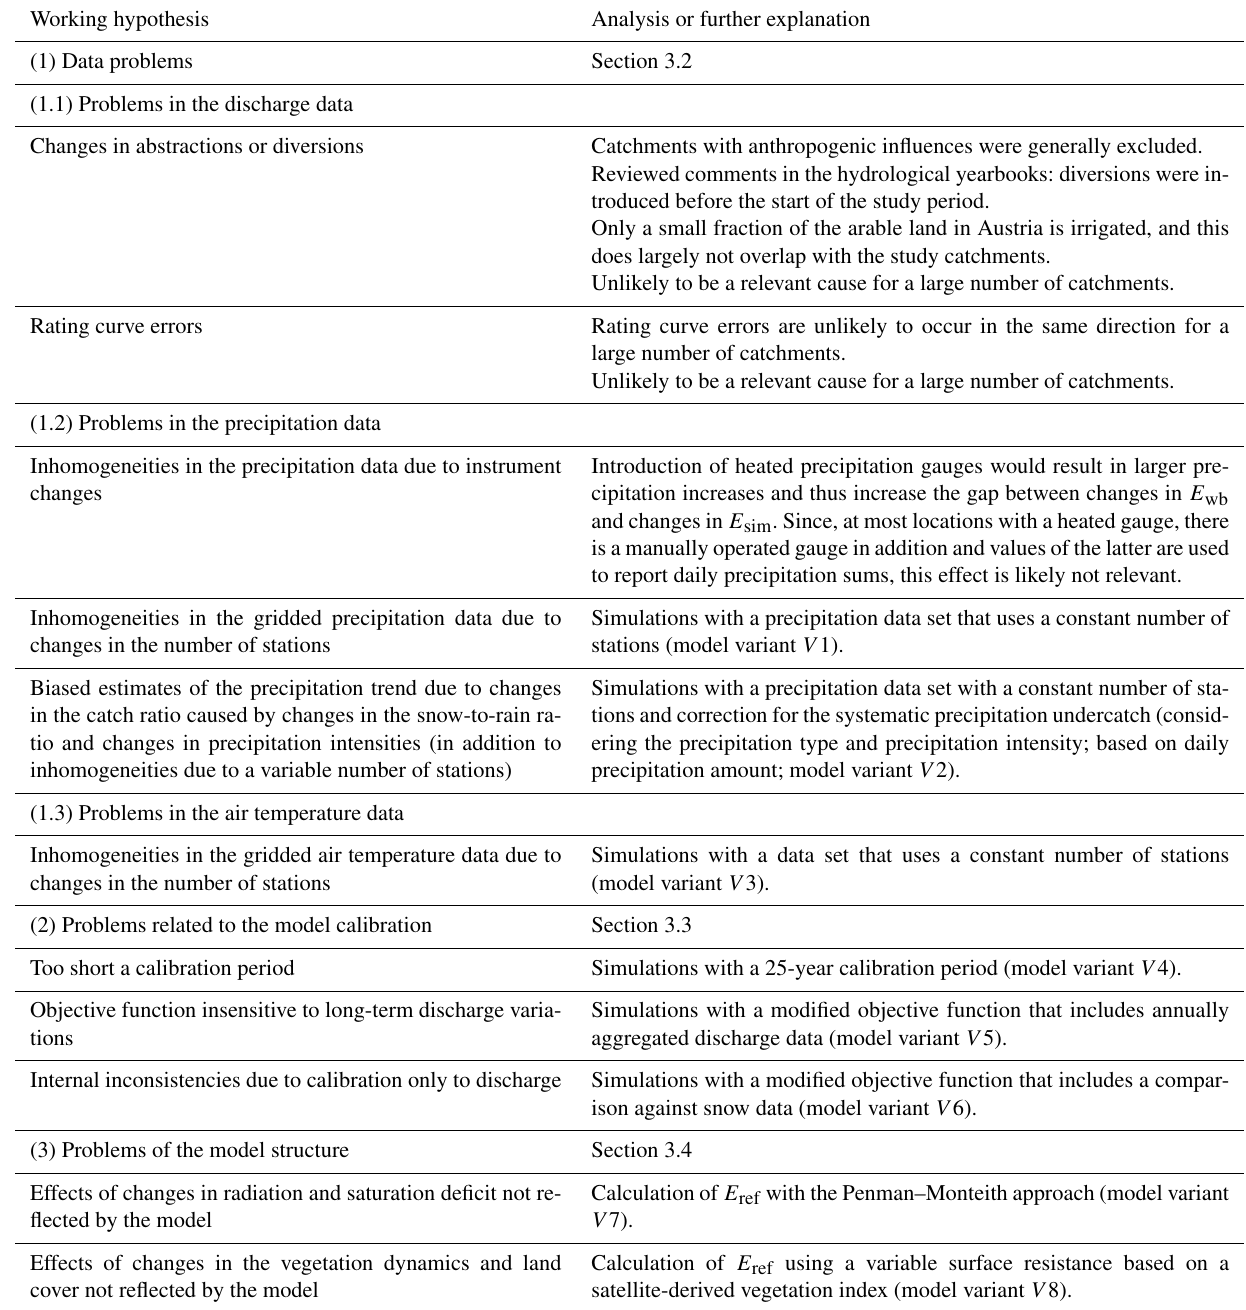
Table 2. Working hypotheses for potential causes of the divergence between observed and simulated discharge